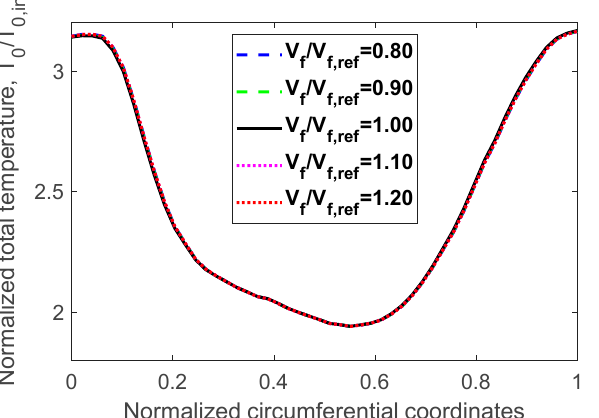
Figure 18. Total temperature circumferential distribution at the combustor outlet mid-span for different values of fuel injection velocity.